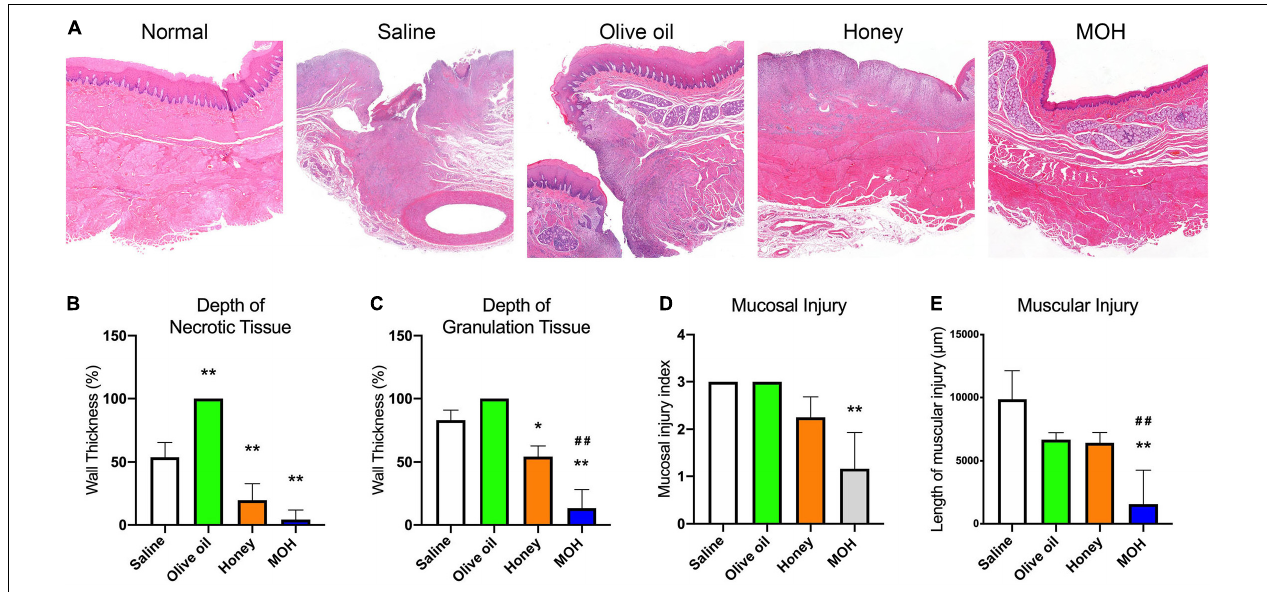
FIGURE 4 | The histological assessment of the damaged esophagi in vivo by the button battery ingestion ( n = 3). (A) Hematoxylin and eosin staining of the battery-damaged esophagi. (B) The necrosis depth of esophageal wall. (C) The depth of granulocytes infiltration into the esophageal wall. (D) The mucosal injury index based on hematoxylin and eosin staining. (E) The muscular injury length of the damaged esophageal tissue. * P < 0.05 vs. Saline; ** P < 0.01 vs. Saline; ## P < 0.01 vs.